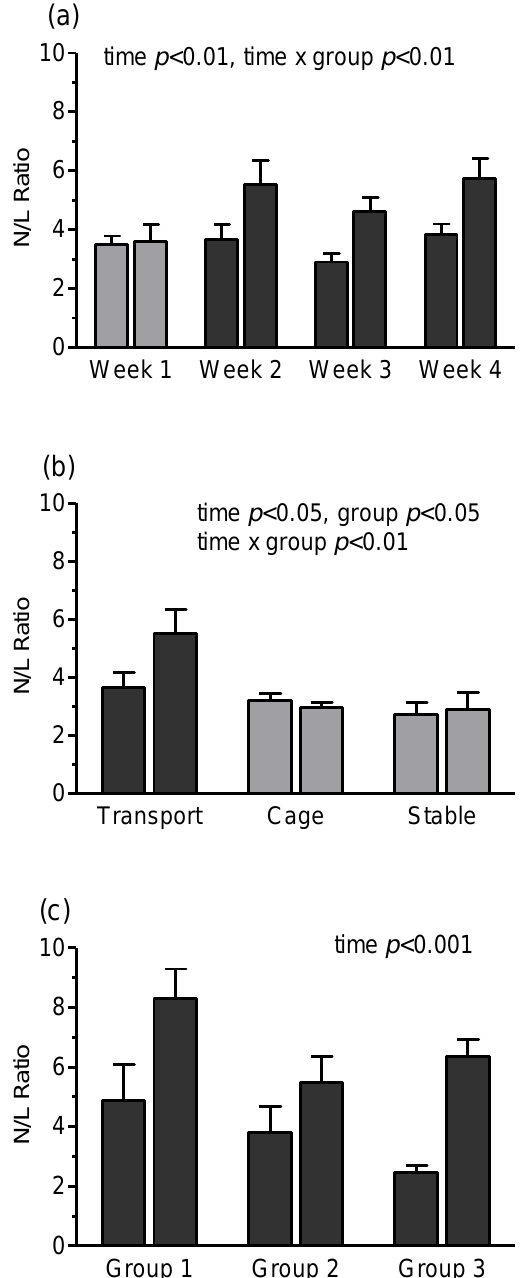
Figure 2. Neutrophil / lymphocyte (N / L) ratio at 60 min before and 60 min after experiments in ( a ) the same dogs ( n = 6) either resting in their stable (week 1) or transported by road for one hour at one week intervals (weeks 2–4); ( b ) three groups of dogs ( n = 6 each) either transported by road for one hour, placed in the transport cage in a stationary car or remaining in their stable; and ( c ) the same three groups of dogs transported by road for two hours, black bars = transport, grey bars = respective control experiments. Values are means ± SEM, significant differences are indicated in the figures.